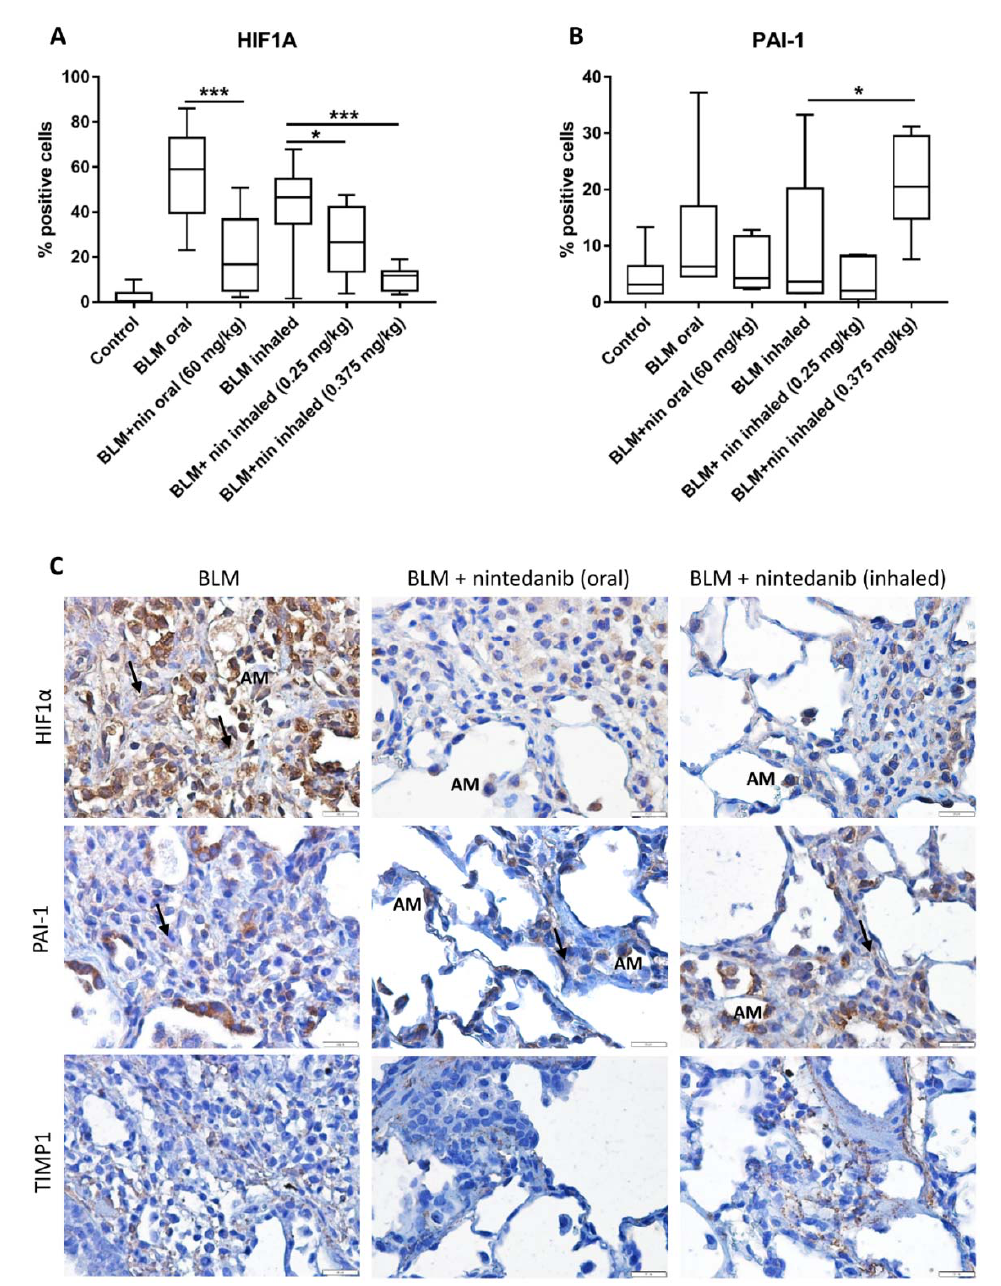
Figure 4 . Rat Bleomycin model shows elevated levels of HIF1 α within fibrotic tissue. Formalin fixed paraffin embedded (FFPE) sections of rats treated with vehicle (control), bleomycin (BLM) with/without oral or inhaled nintedanib (nin) were stained for HIF1 α ( A ) ( n ≥ 7), PAI-1 ( B ) ( n ≥ 6) and TIMP1 by IHC and counter stained by hematoxylin. ( C ) Representative IHC for figures A , B and for TIMP1. * p < 0.05, *** p < 0.001. AM-alveolar macrophages, arrows indicate fibroblasts. Magnification (X400). Arrows indicate staining of fibroblasts.